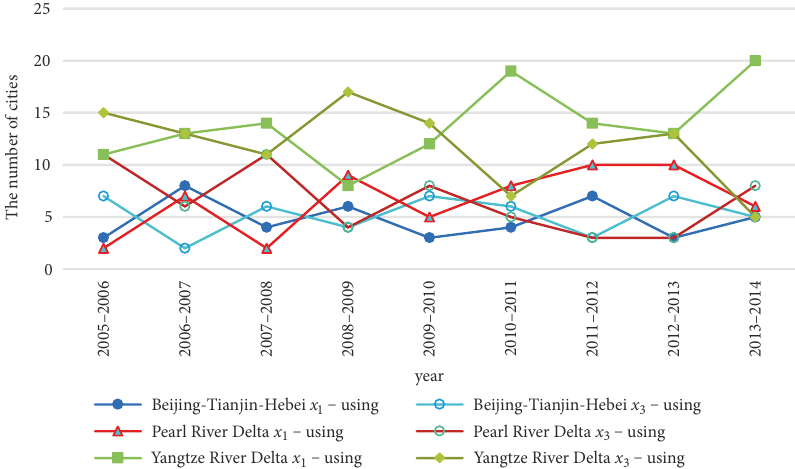
Figure 4. Input biased technological changes of capital stock ( x 1 ) and electricity consumption ( x 3 ) in each of the urban